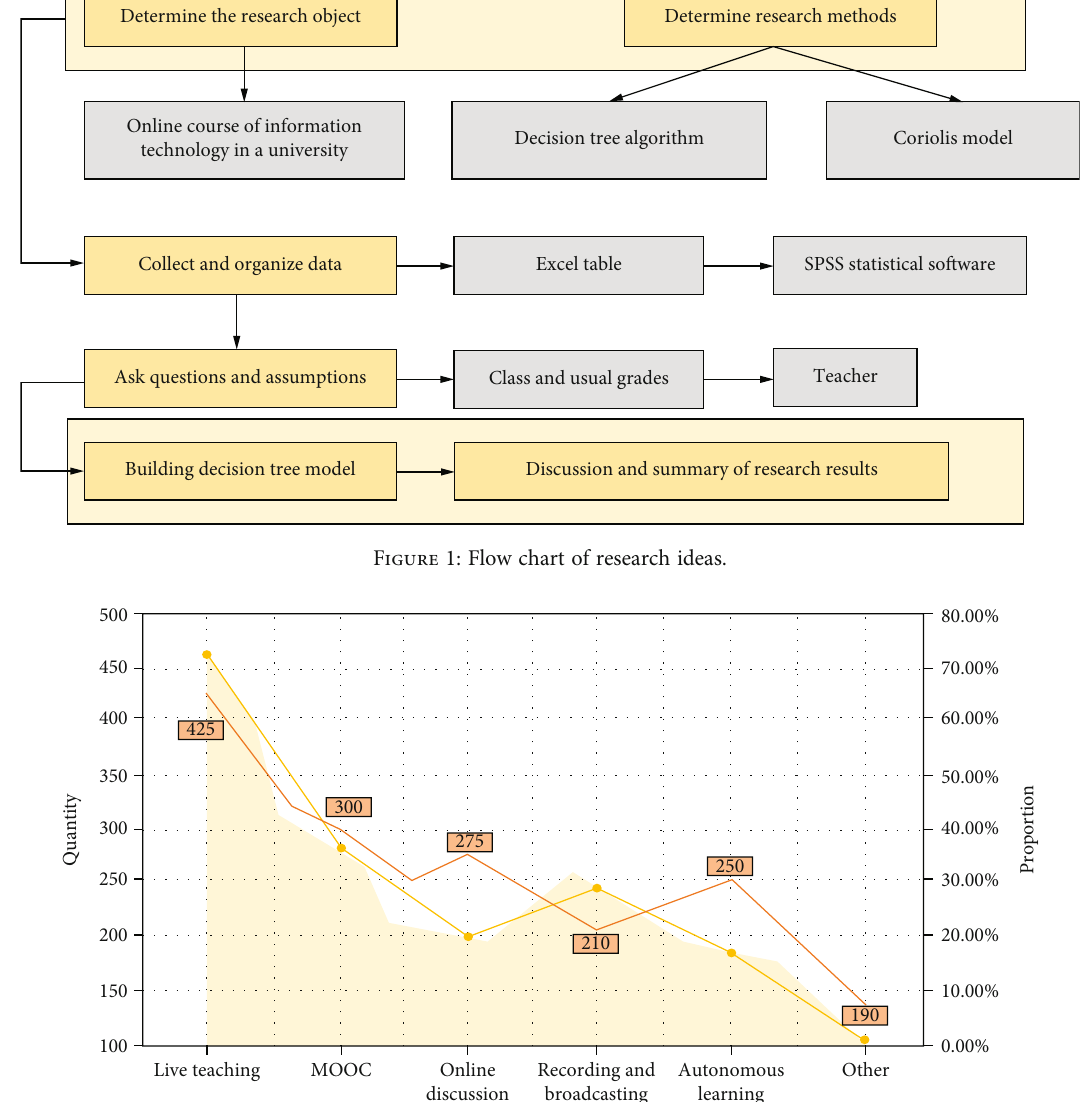
Figure 2: Display diagram of data change and proportion change of online teaching